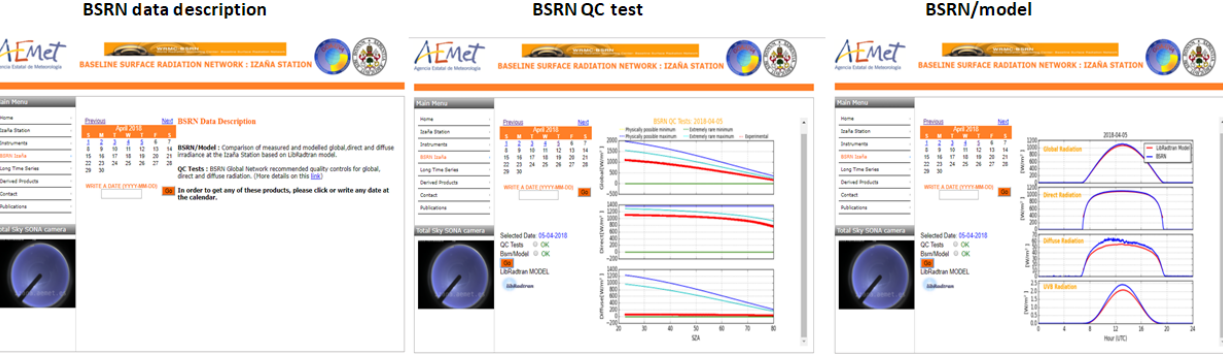
Figure 12. BSRN Izaña: BSRN data description, QC test (BSRN global network recommended QC for SWD, DIR and DIF) and BSRN– model comparison for SWD, DIR, DIF and UV-B radiation at IZA using the LibRadtran RTM (http://www.bsrn.aemet.es, last access: 7 February